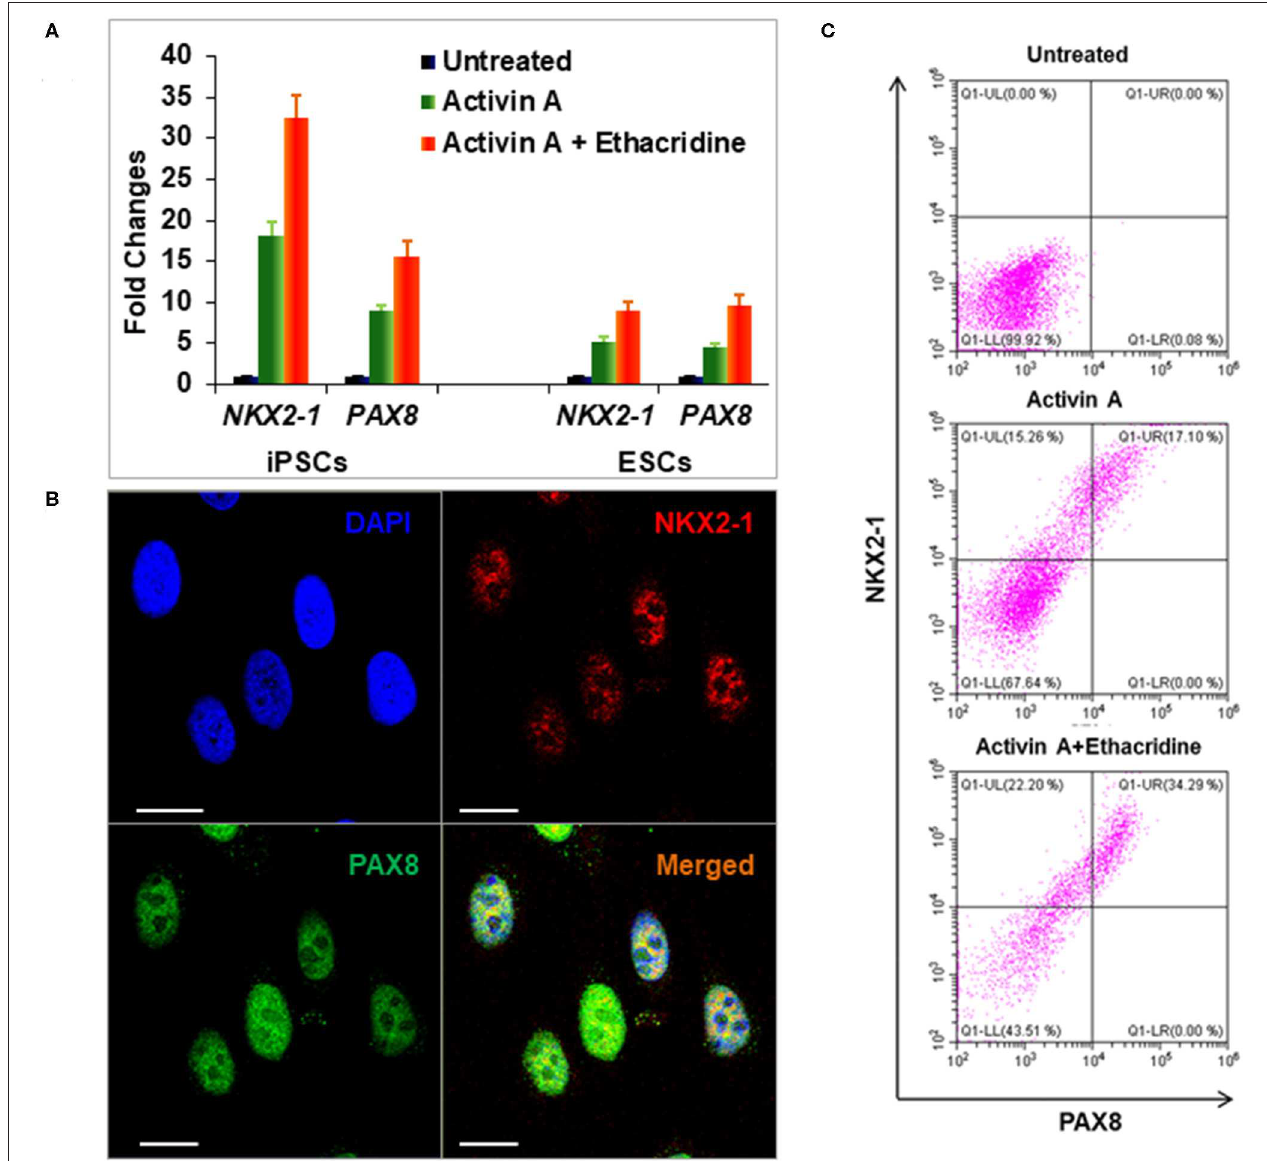
FIGURE 4 | Differentiation of definitive thyroid endoderm from human iPSCs (LF cells). (A) qPCR analysis of thyroid transcriptional factors NKX2-1 and PAX8 in human ES cells and human iPSCs (LF cells). Fold change is represented as the mean ± SEM of three independent experiments. (B) Immunostaining of NKX2-1 (Red) and PAX8 (Green) in human iPSCs (LF cells) derived thyroid endoderm cells. Scale bar = 20 µ m. (C) Representative flow cytometry of NKX2-1 and PAX8 expressing cells in untreated (upper), activin A treated (middle) and activing A + Ethacridine (lower) cells. Data were representative of three separate experiments.